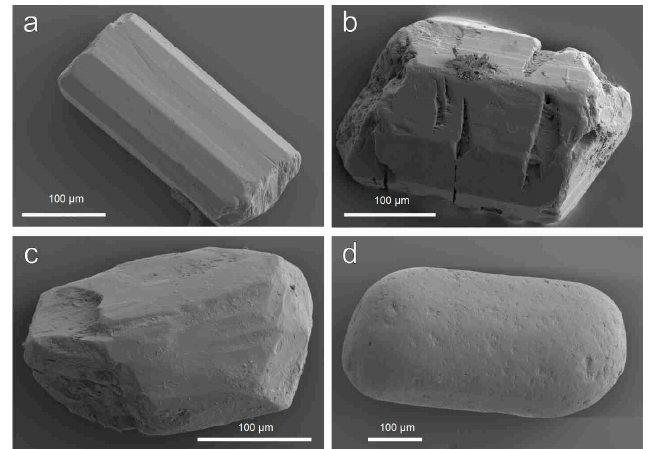
Figure 5. SEM–SE (Scanning Electron Microscope-Secondary Electron) images of tourmaline types in terms of their roundness and deterioration degree; ( a ) Angular grain, Glanów–Stroniczki, ( b ) Subangular grain with etchings, Lelów, ( c ) Subrounded grain, Mokrzesz, ( d ) Rounded grain, Korzkiew; scale bars are 100 μ m.